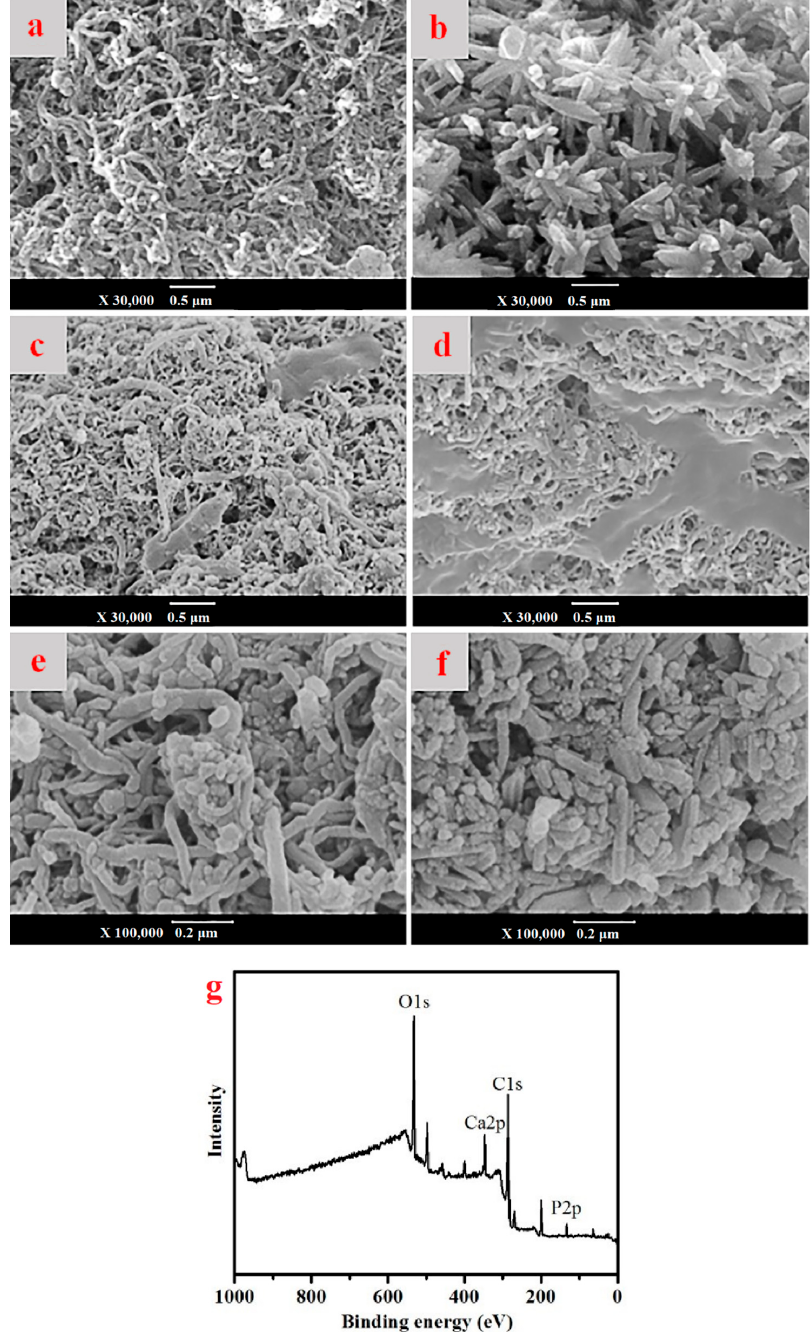
Figure 3. SEM images of CaP crystals on NS-CNTs under deposition time of ( a ) 15 min and ( b ) 30 min; SEM images of nHA coating on NS-CNTs under soaking in SBF for 24 h after deposition time of ( c , e )15 min and ( d , f ) 30 min; ( g ) XPS spectrum of nHA-CNTs.